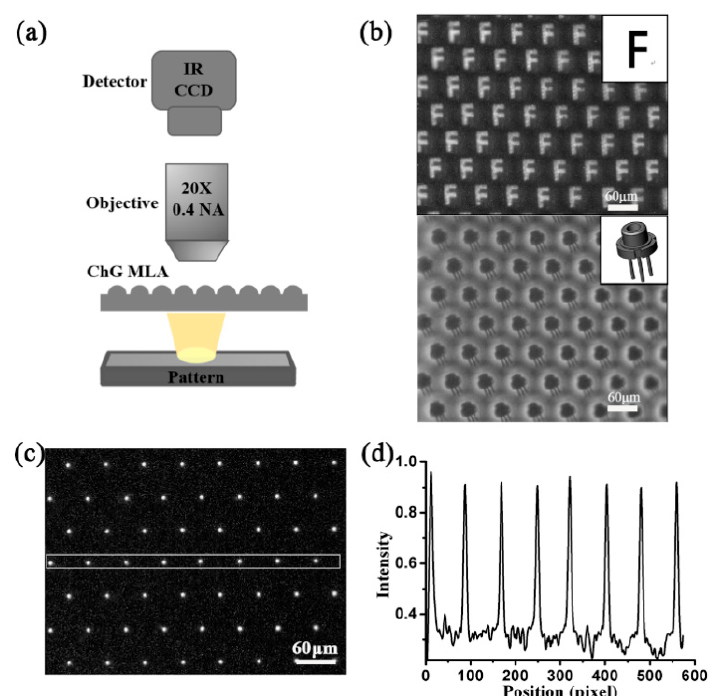
Figure 7. ( a ) The optical characterization IR system for ChG MLAs. ( b ) Clear IR images obtained from the ChG MLAs. ( c ) The focal point is observed with an IR charge coupled device (CCD), and the focal length is measured to be about 34 µ m. ( d ) The normalized intensity distribution obtained in the selected rectangular area.